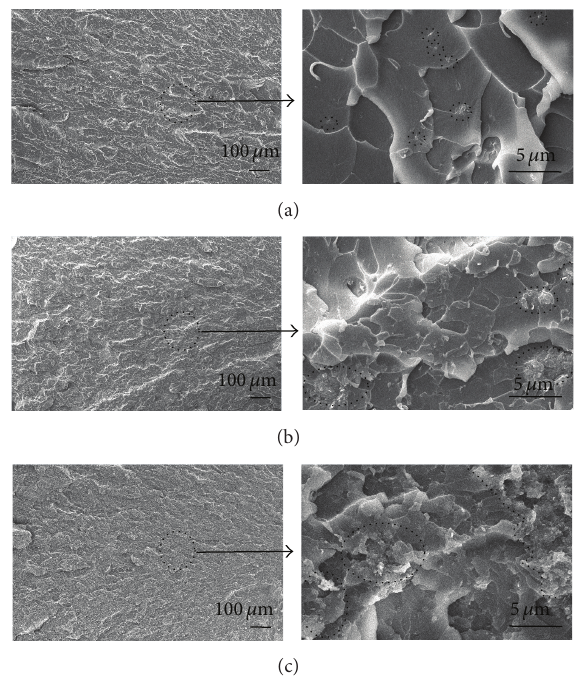
Figure 5: SEM micrographs of flexural fracture surface of GNP filled epoxy composites at 0.4 (a), 1 (b), and 5vol.% (c).